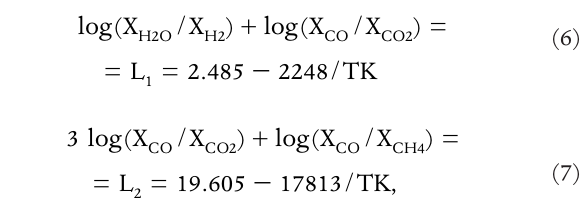
, CO and H S re-equilibration in the vapor phase 2 2